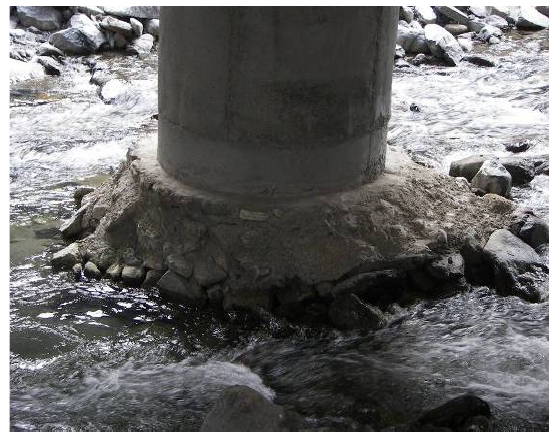
Figure 2. Local scour near longitudinal bridge piers.